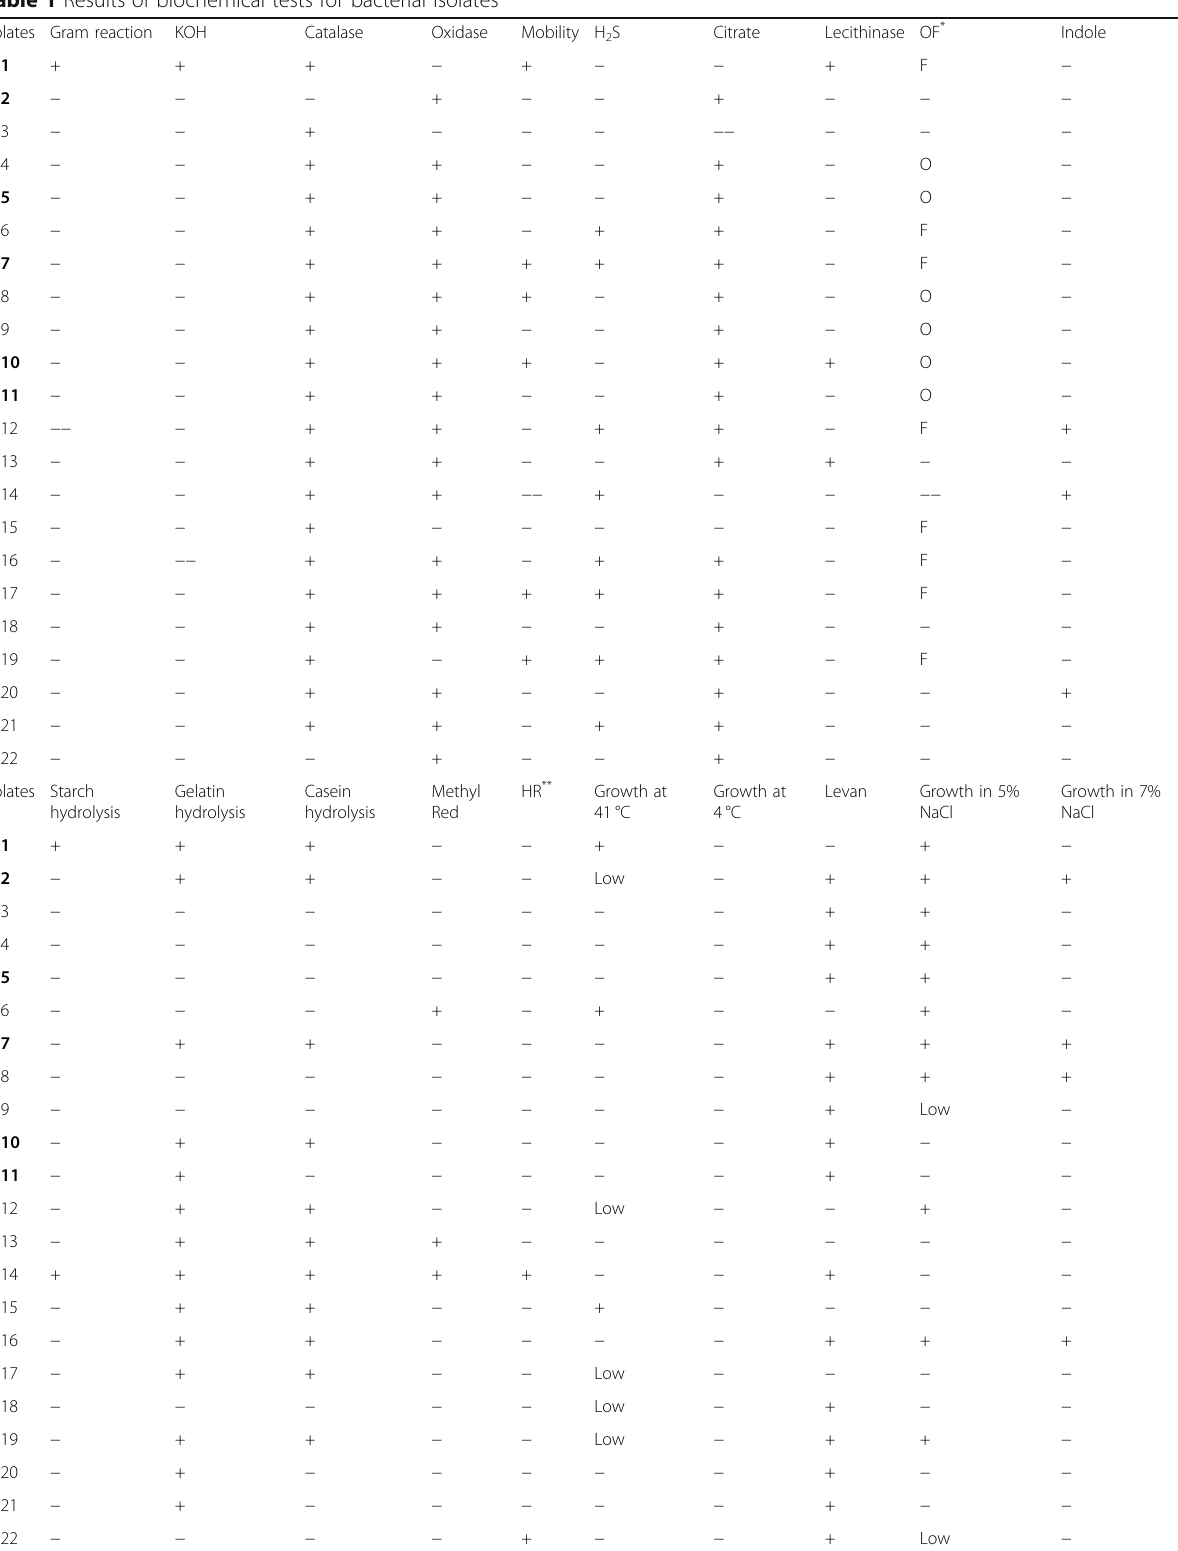
Table 1 Results of biochemical tests for bacterial